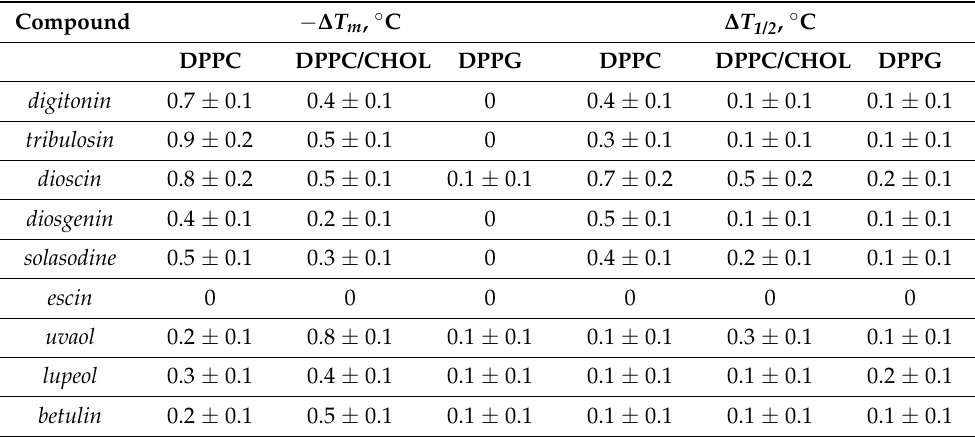
Figure 4. Heating thermograms of DPPC ( a ), DPPC/CHOL, ( b ) and DPPG ( c ) unilamellar liposomes in the absence and presence of saponins and related compounds at the concentration of 50 µ M. Table 3. Parameters charactering the effects of saponins and related compounds on the elastic properties of lipid bilayers at 50 µ M: ∆ T m —the changes in the main transition temperature; ∆ T 1/2 — the changes in the half-width of the main